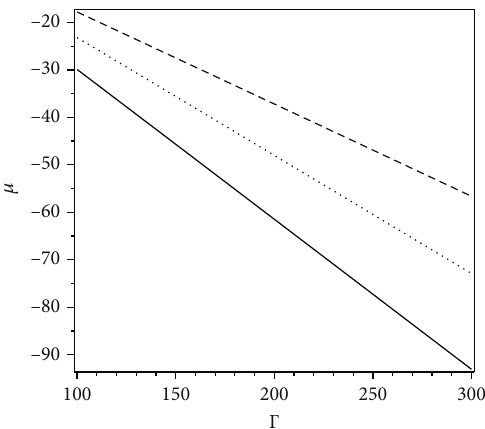
Figure 1: Compressibility variations with the coupling parameter for di ff erent values of the structure parameter, k = 0 : 4 (solid line), k = 0 : 8 (dot line), and k = 1 : 2 (dashed line).